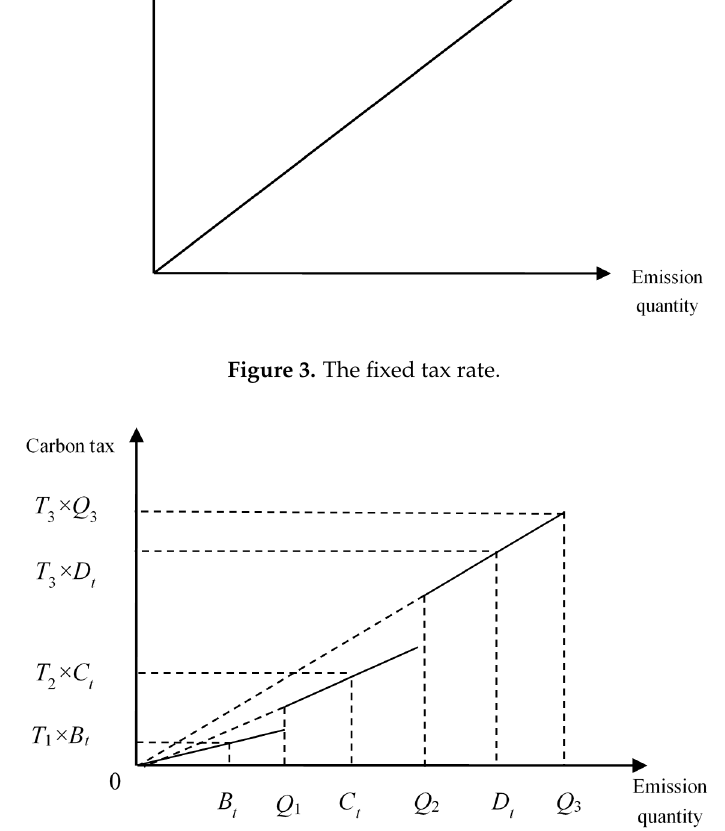
Figure 4. The full progressive tax rate without a threshold.